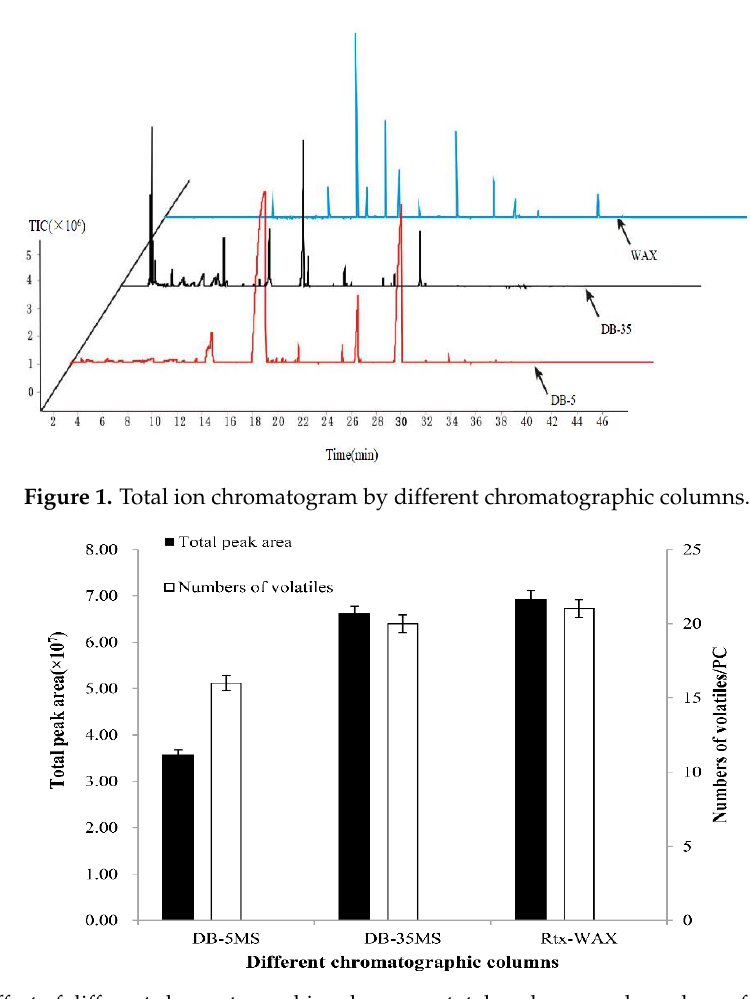
Figure 2. Effect of different chromatographic columns on total peak area and numbers of volatiles from stink tofu brine.